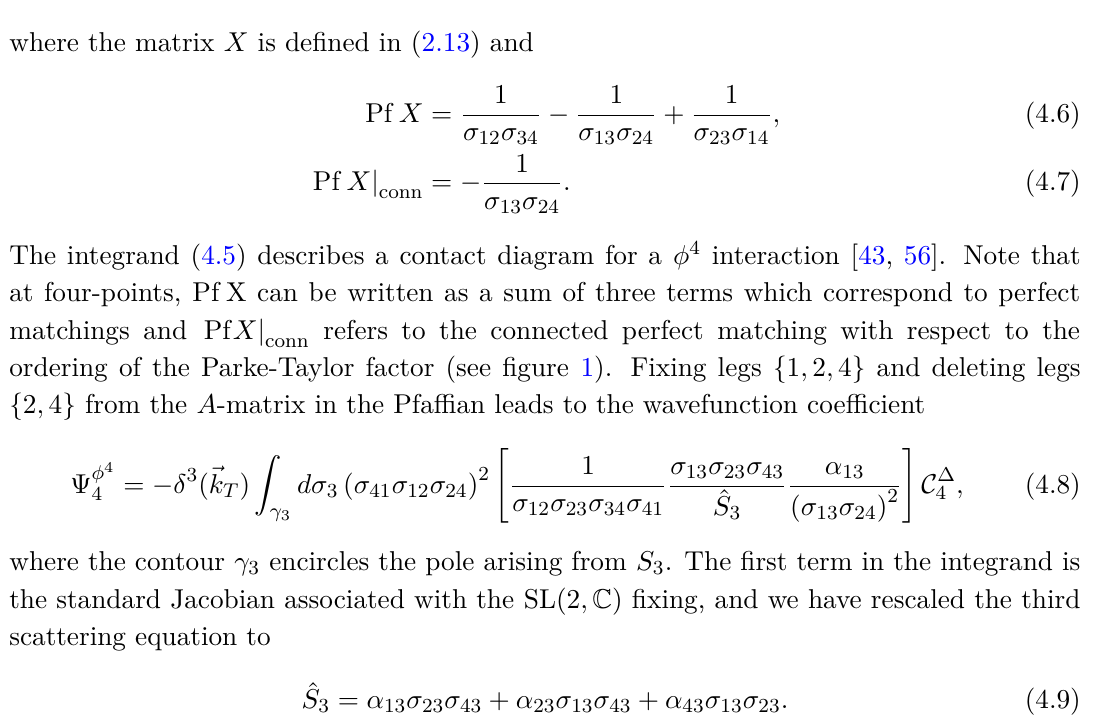
Figure 1 . Graphic representation of PT Pf X | conn . The circle refers to the PT factor while the intersecting lines correspond to Pf X | conn